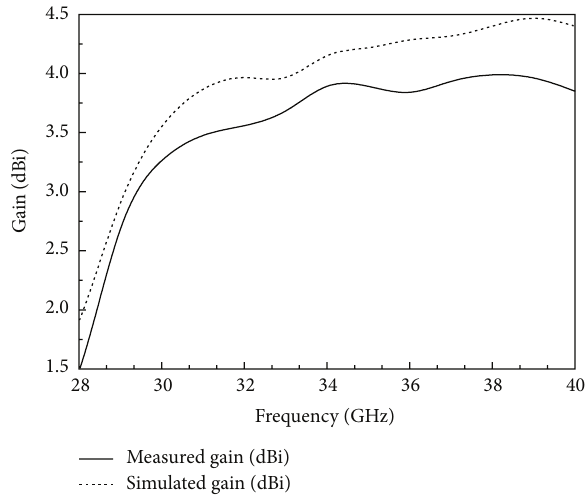
Figure 5: Simulated and measured gain of the proposed antenna.